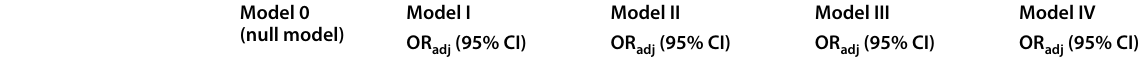
Table 3 Multilevel mixed effects logistic regression showing predictors of multiple sexual partnership among adolescent boys and young men between 2003 and